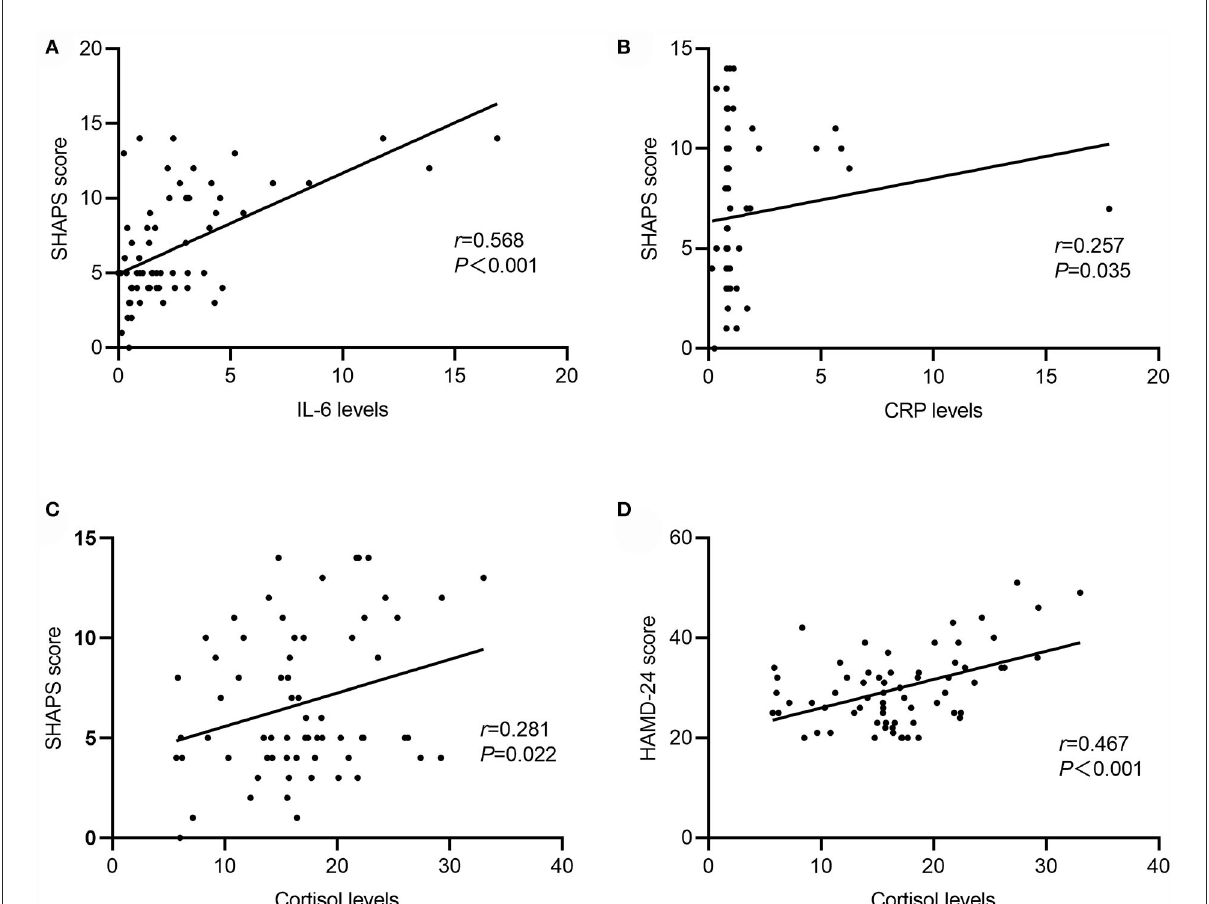
FIGURE2 Correlation between serum cytokines, CRP, cortisol, Snaith-Hamilton Pleasure Scale (SHAPS), and Hamilton Rating Scale for Depression-24 (HAMD-24) in MDD. (A) IL-6 levels were positively associated with SHAPS score ( r = 0.568, P < 0.001); (B) CRP levels were positively associated with SHAPS score ( r = 0.257, P = 0.035); (C) cortisol levels positively associated with SHAPS score ( r = 0.281, P = 0.022); (D) cortisol levels were positively associated with HAMD-24 score ( r = − 0.467, P < 0.001).